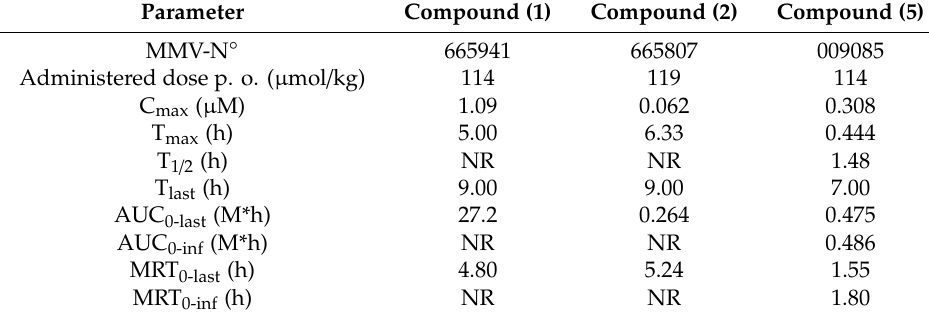
Table A2. Pharmacokinetic data of the compounds (1), (2), and (5) obtained after peroral dosing of these compounds in mice. AUC 0-last , area under the curve from time point 0 to T last ; AUC 0-inf , AUC 0-last extrapolated to indefinite time point; C max , maximal plasma concentration; MRT 0-last , MRT 0-inf , mean residence time from 0 to T last or indefinite; NR, not recorded; p.o., peroral; T 1 / 2 , half-life; T max , time point of maximal concentration; T last , time point of last measurable concentration. The data were kindly provided